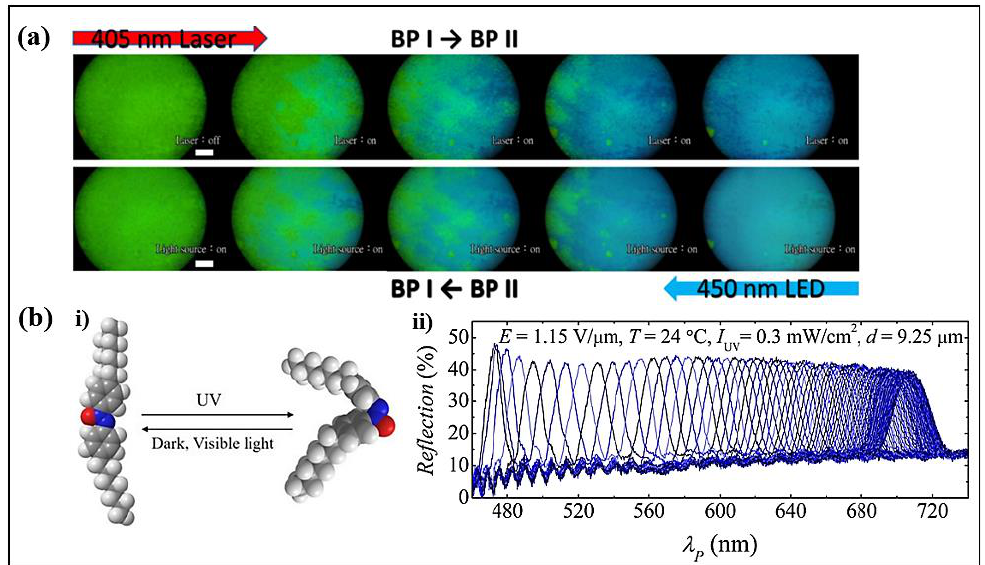
Figure 6. ( a ) Polarizing optical microscopic images of the aligned chiral – azobenzene-doped BPLCs sample during the illumination of different light sources. Reproduced with permission from Ref.